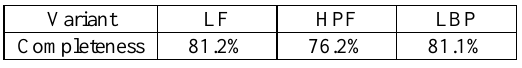
Table 2. Mean completeness crack detection process in all 20